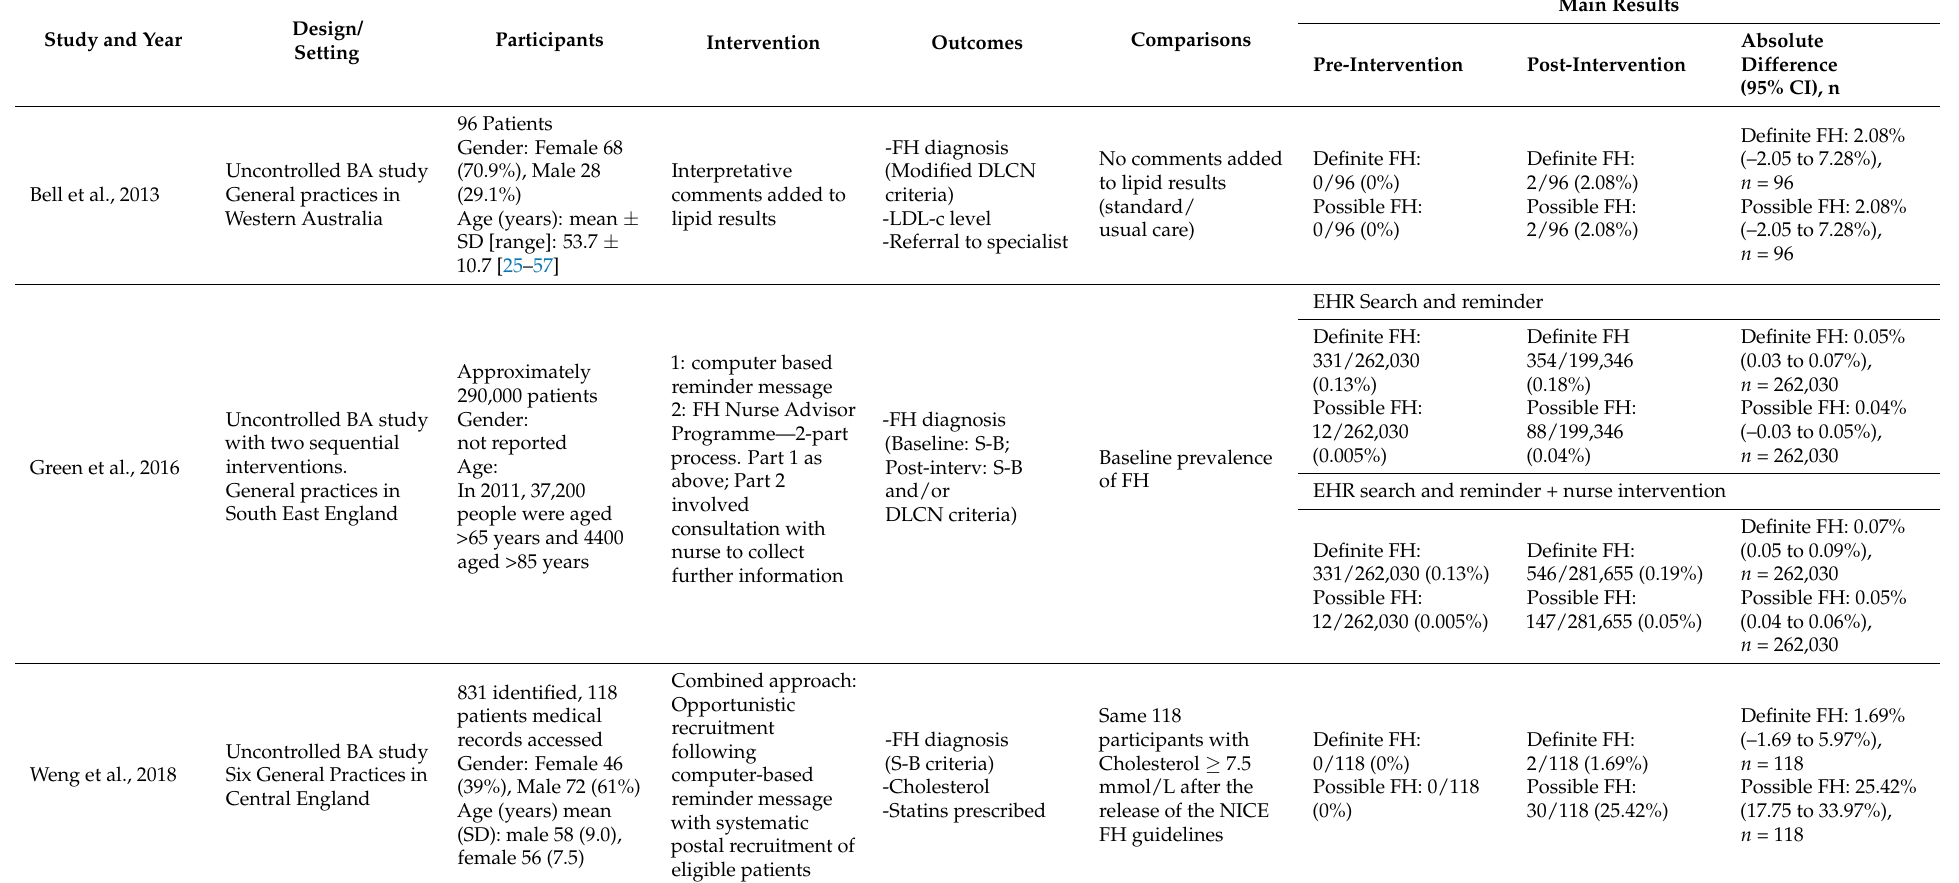
Table 1. Summary of included